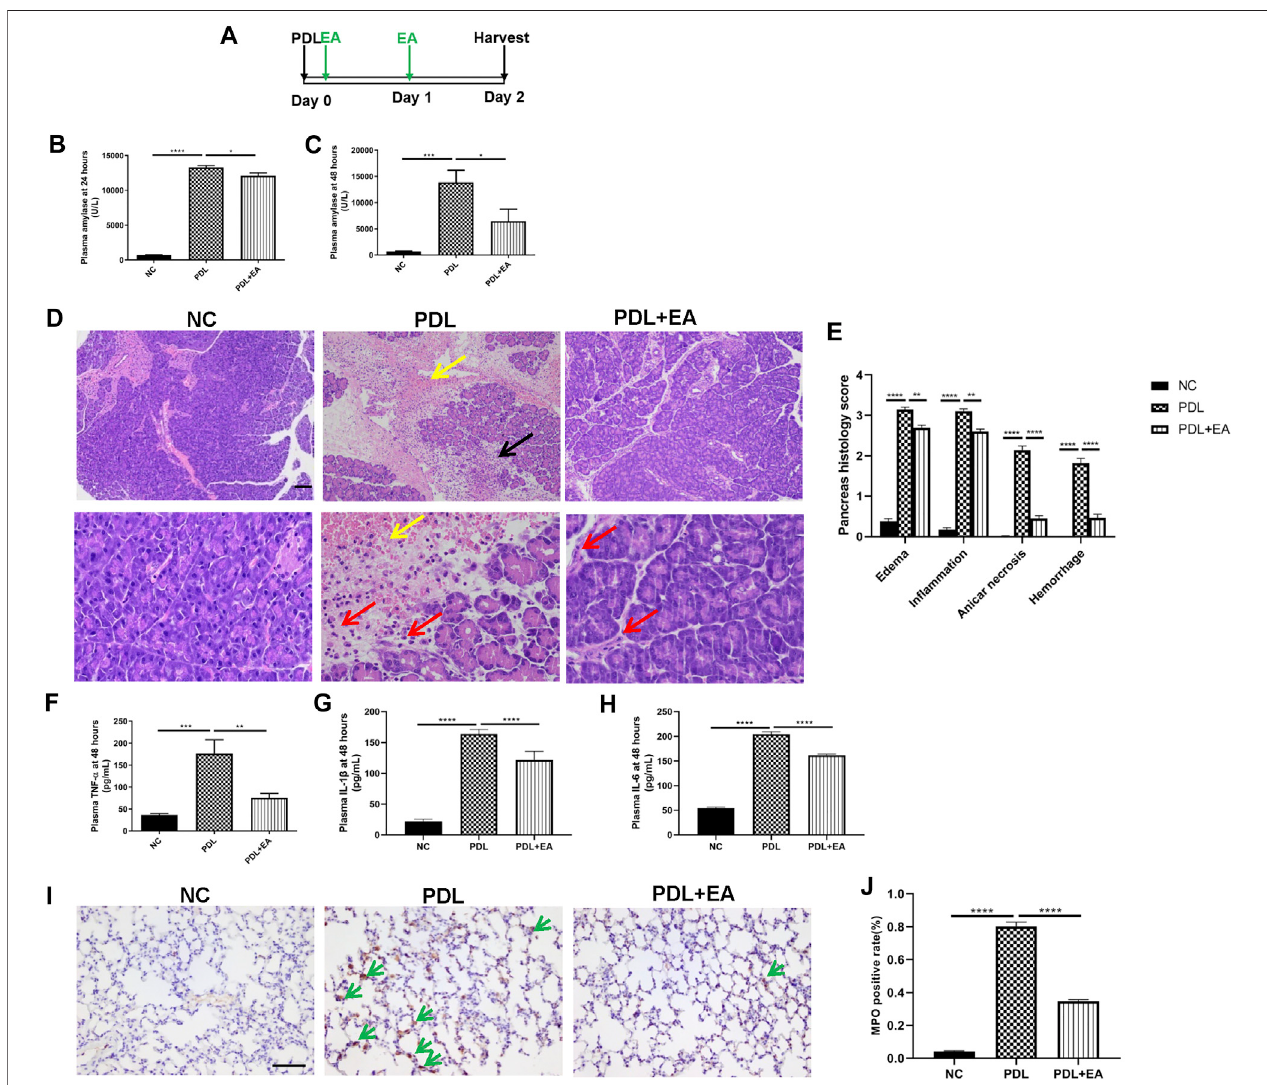
FIGURE6| EAalleviatespancreasinjuryandsystemicin fl ammationinPDL-inducedpancreatitis. (A) Schematicdescriptionoftimeline. (B) Plasmaamylaseactivity at 24 h after PDL operation. (C) Plasma amylase activity at 48 h. (D) Representative H&E staining of pancreas sections (scale bars: 100 μ m). Yellow arrow represents pancreas hemorrhage, black arrow represents pancreas necrosis, and red arrow represents in fi ltrating cells. (E) The pancreas histological score. (F) Plasma TNF- α at 48 h. (G) PlasmaIL-1 β at48 h. (H) PlasmaIL-6at48 h. (I) RepresentativeimmunohistochemicalimagesofMPOexpressioninthelung(scalebars:100 μ m).Green arrow represents in fi ltrating MPO + neutrophils. (J) Quantitative summary of MPO expression, n (cid:1) 9. Bars show mean ± SEM. * p < 0.05, ** p < 0.01, *** p < 0.001, and **** p < 0.0001. NC, normal control; PDL, pancreatic duct ligation; EA, electroacupuncture.